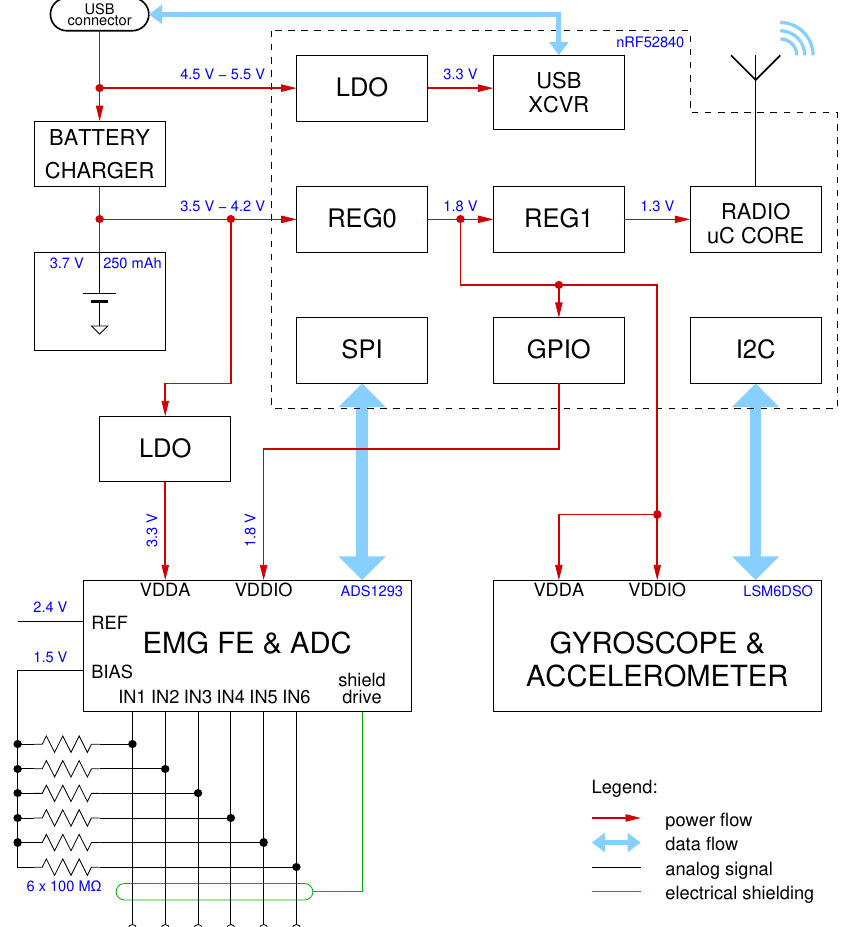
Figure 1. Block diagram of the sensor node highlighting the various power supply subsystems exploited to minimize energy consumption and the data interfaces. The ADS1293 acquires the analog signals and transmits them to the SoC through a serial peripheral interface (SPI) when enabled by the general- purpose input/output (GPIO) line. The LSM6DSO integrates the inertial platform and streams its data to the microcontroller (uC) through an inter-integrated circuit (I2C)